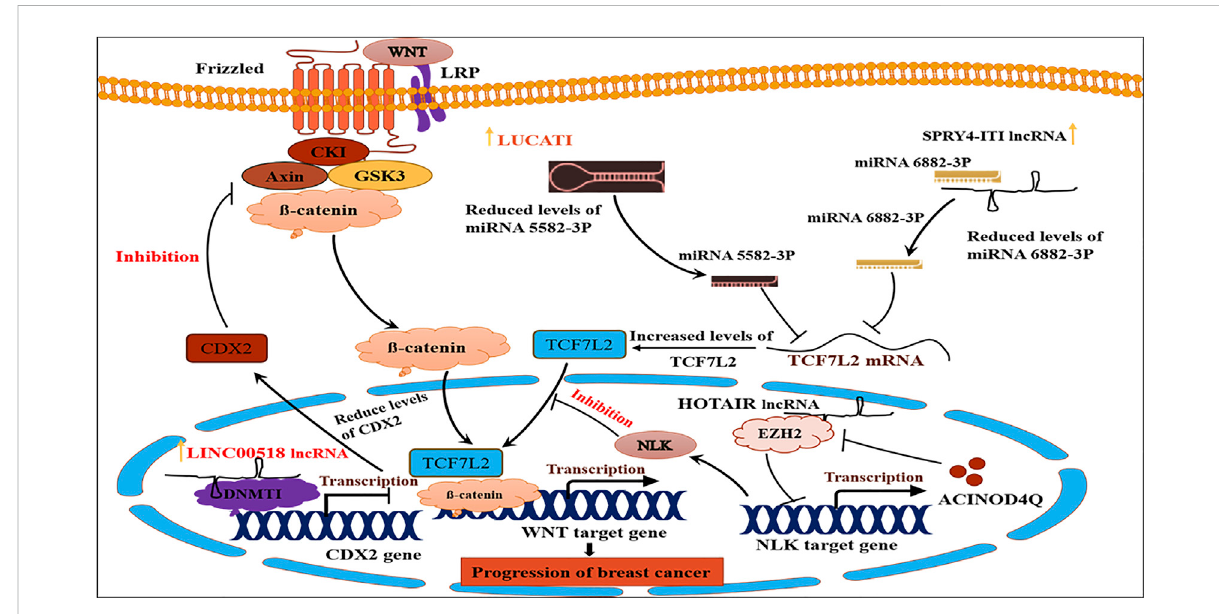
FIGURE 5 Showing long noncoding RNAs mediated different cancer related signaling pathways. Adapted from (Ghafouri-Fard et al.,